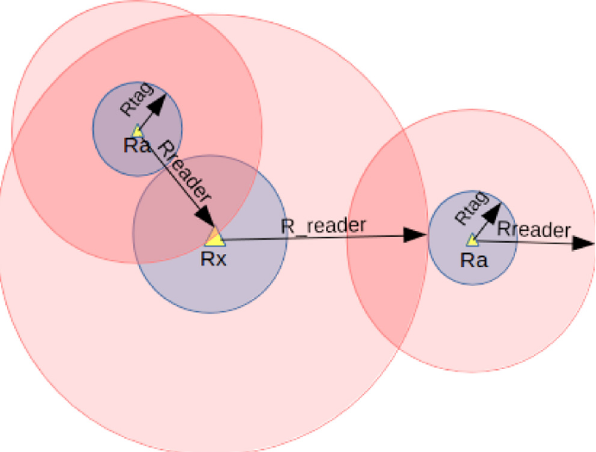
Figure 6. Reader-to-reader collision zones for heterogeneous RFID